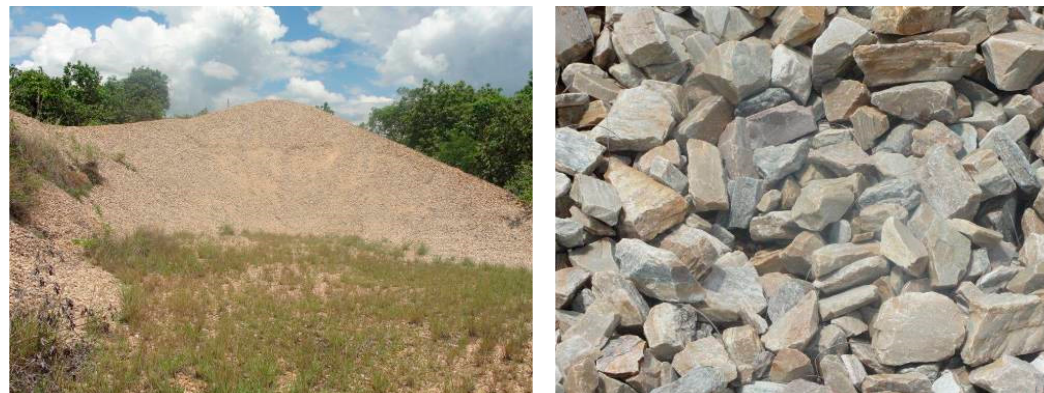
Figure 1. Quartzite deposit.